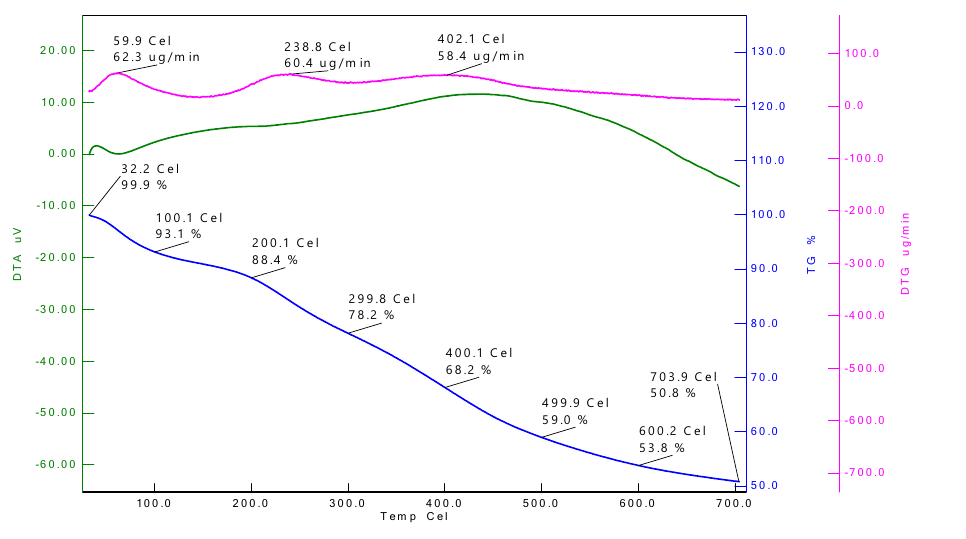
Figure 7. XPS deconvoluted spectra of carbon, oxygen, sulfur and overall spectra.